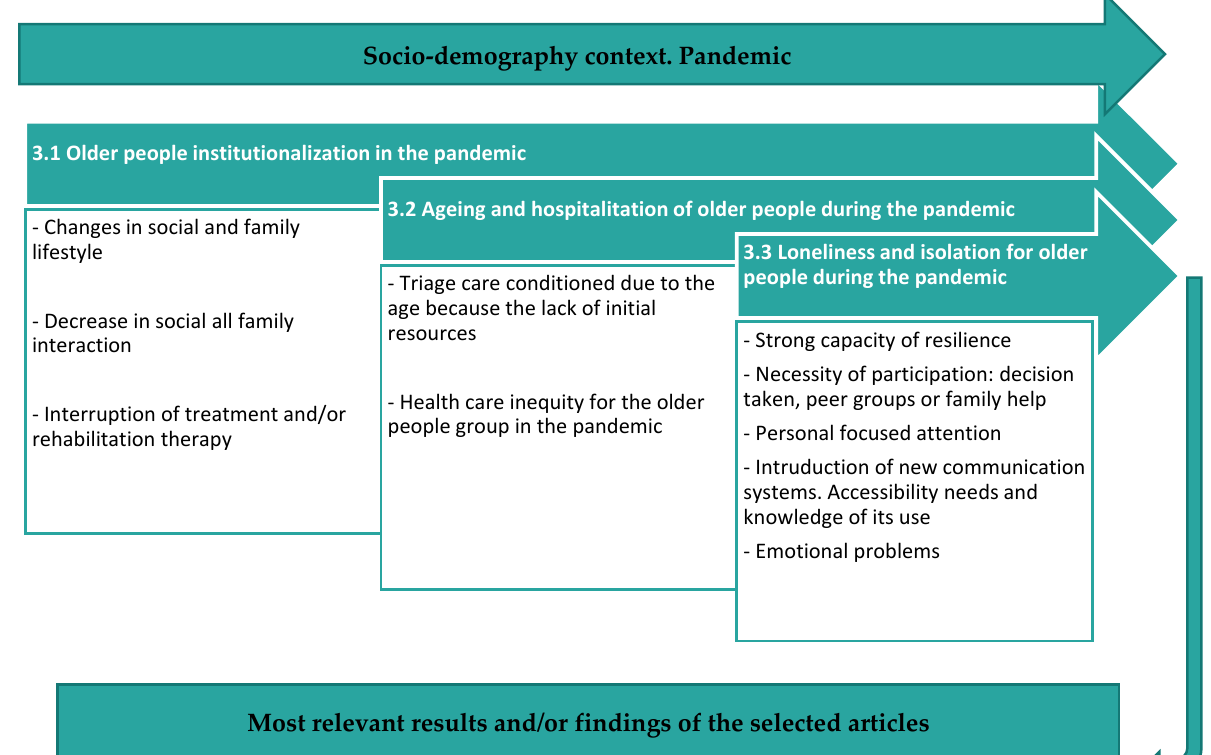
Figure 2. Diagram of the situation during the pandemic of the elderly according to the selected articles. Source: own authors.